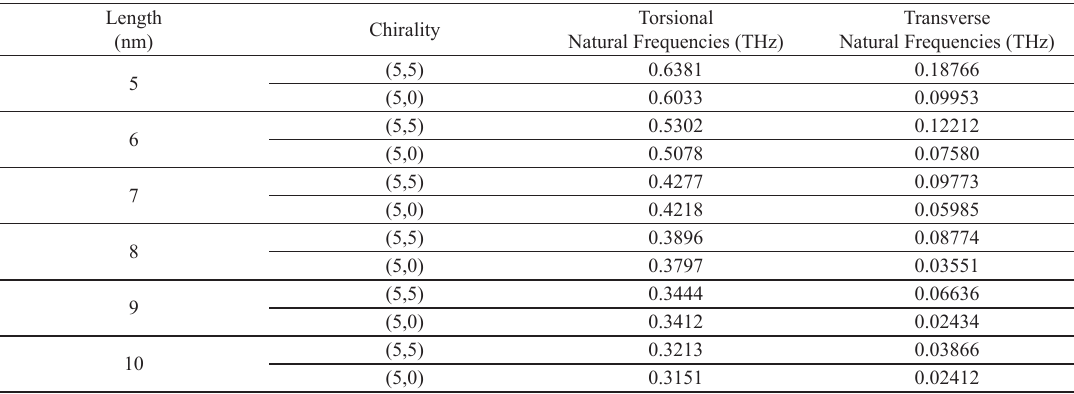
Table 3. Natural frequencies (THz) of free vibration due to torsional and transverse excitation of armchair (5,5) and zigzag (5,0) SiNT with different lengths calculated by MD simulations.